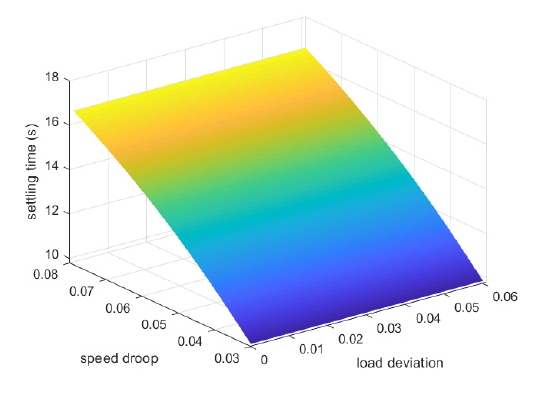
Figure 10. Composite influence on the peak frequency.